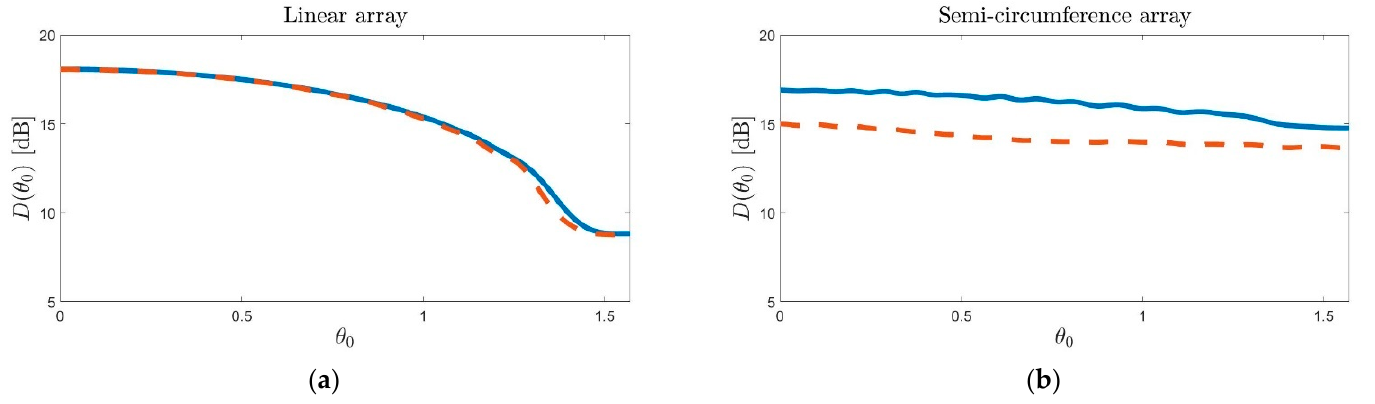
Figure 3. The directivity upper-bound (4) (blue line) and the directivities (10) and (11) (dashed red line), respectively, for a linear ( a ) and semi-circumference ( b ) array with 41 isotropic elements and length L = 20 λ . For symmetry reasons, only the interval (cid:4670)0, π/2(cid:4671) is plotted.